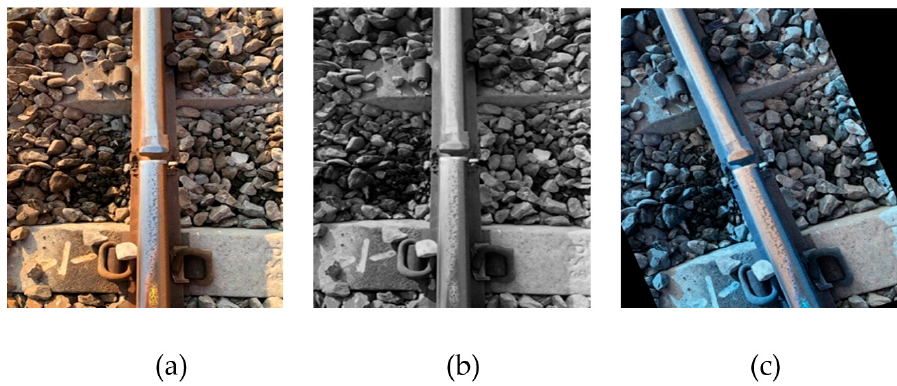
Figure 6. Examples of data augmentation. ( a ) original; ( b ) gray; ( c ) rotation.